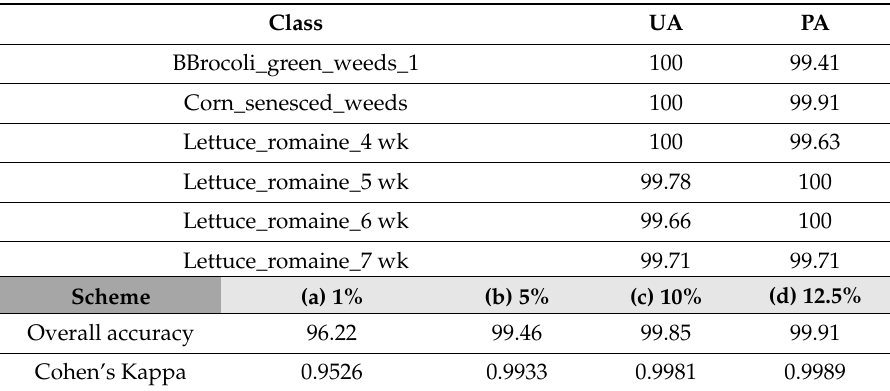
Table 7. User’s and Producer’s accuracy results (using 10% of the available training sample for the dataset), Overall accuracy and Cohen’s Kappa of the HDCA with different schemes on the Salinas-A scene.